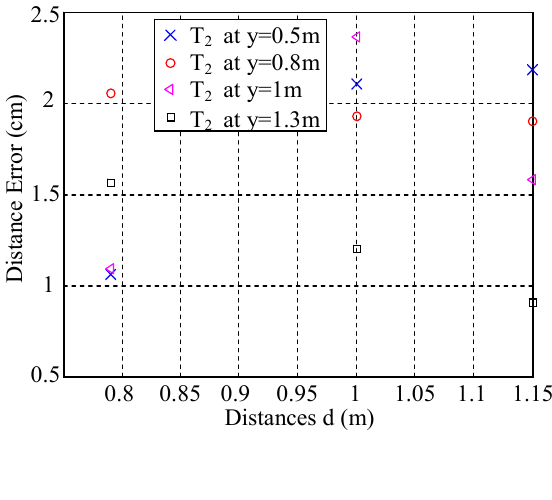
Figure 11. Distance errors estimated with two transponders, with T 1 fixed in front of emitter and for various T 2 position y = 0.5 to 1.3